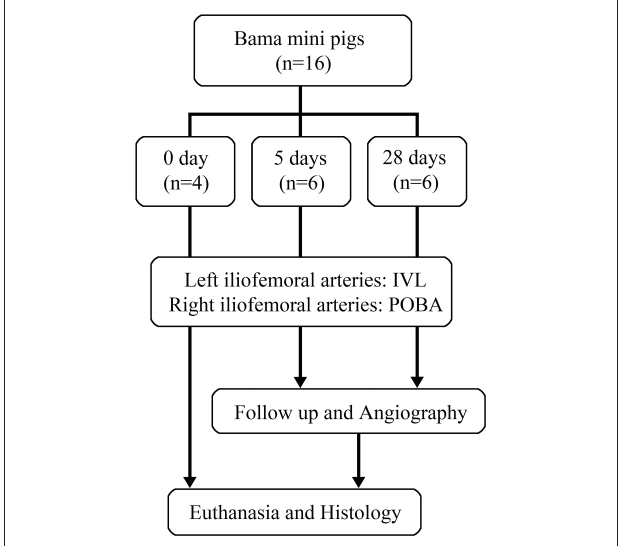
FIGURE 2 | Flowchart of study design. IVL, intravascular lithotripsy; POBA, plain old balloon angioplasty.